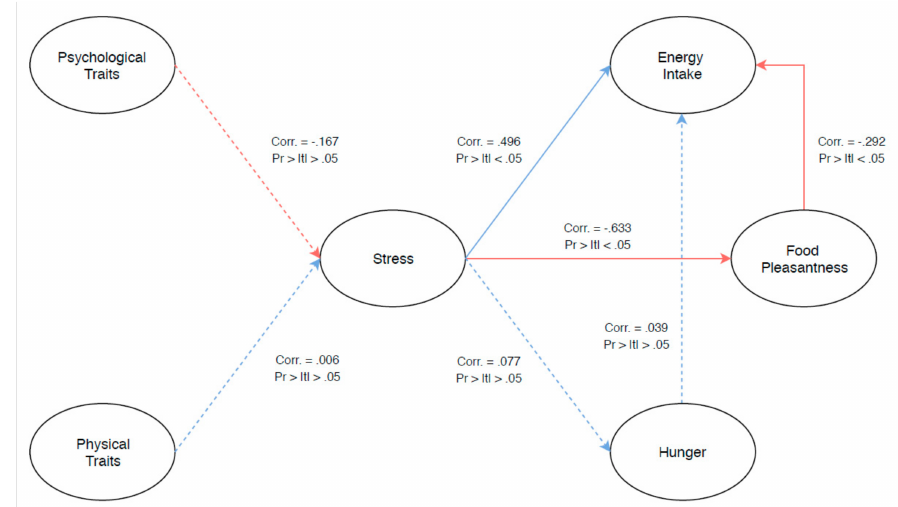
Figure 4. Partial least squares path modeling (PLS-PM) showing the relationship between physical (BMI, Waist circumference, Age, and Gender) and psychological measures (self-rated stress, State–Trait Anxiety Inventory (STAI), and Dutch Eating Behavior Questionnaire (DEBQ) dimensions), as well as energy intake, hunger, and food pleasantness. Solid and dotted lines correspond to significant ( p < 0.05) and non-significant relationship ( p > 0.05), respectively, between the latent